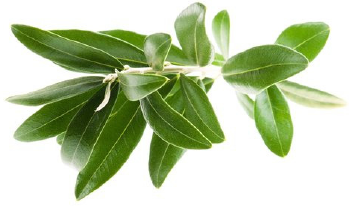
Figure 1. Olive ( Olea europaea L.) leaves [5].